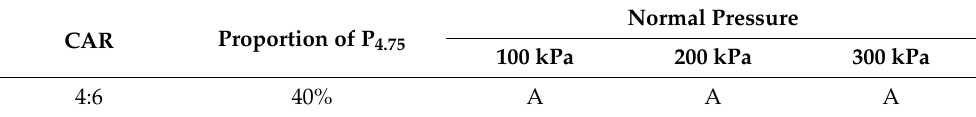
Table 6. Test design of the influence of normal stress on shear strength.